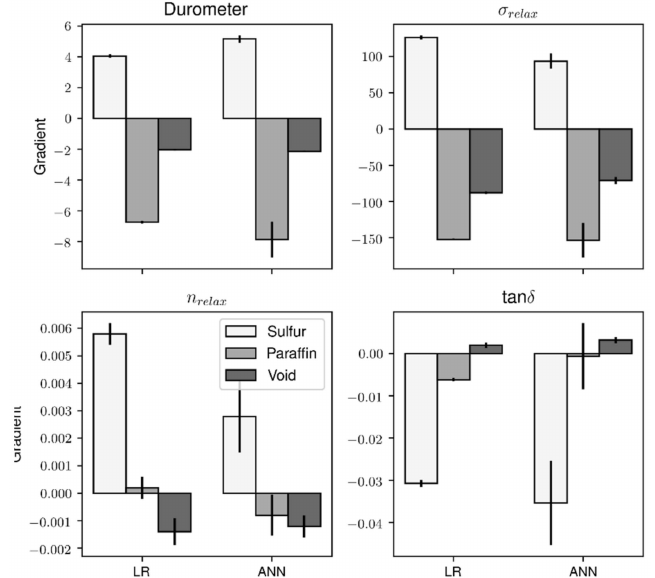
Figure 33. The results from the sensitivity analysis for both the linear regression baseline and the ANNs.